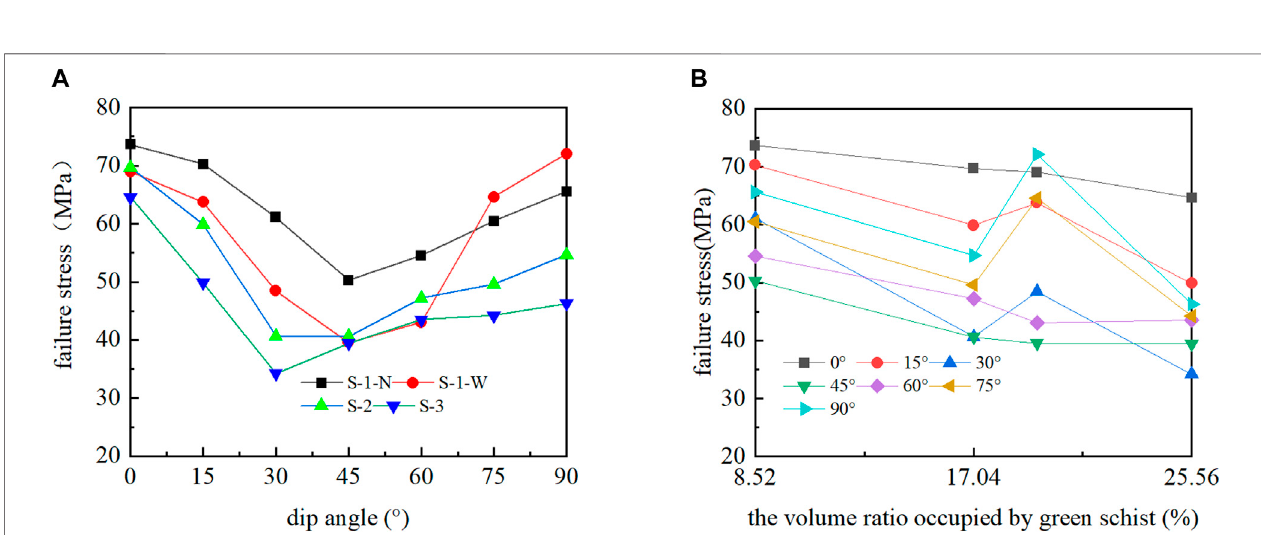
FIGURE 3 | Variation of the failure stress with the dip angle and the volume ratio occupied by green schist.